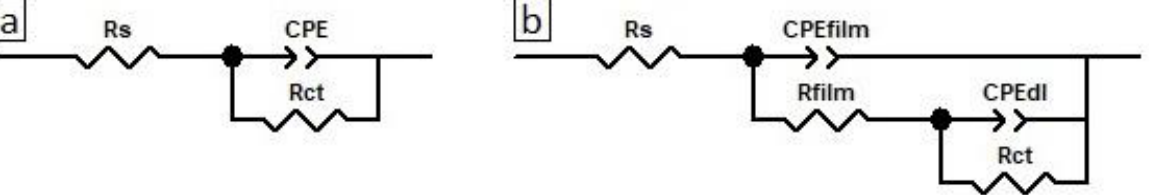
Figure 8. The equivalent electrical circuit used for fitting the experimental impedance data ( a ) in the presence and absence of inhibitor and ( b ) for the base metal/nanoparticle – caffeine system.